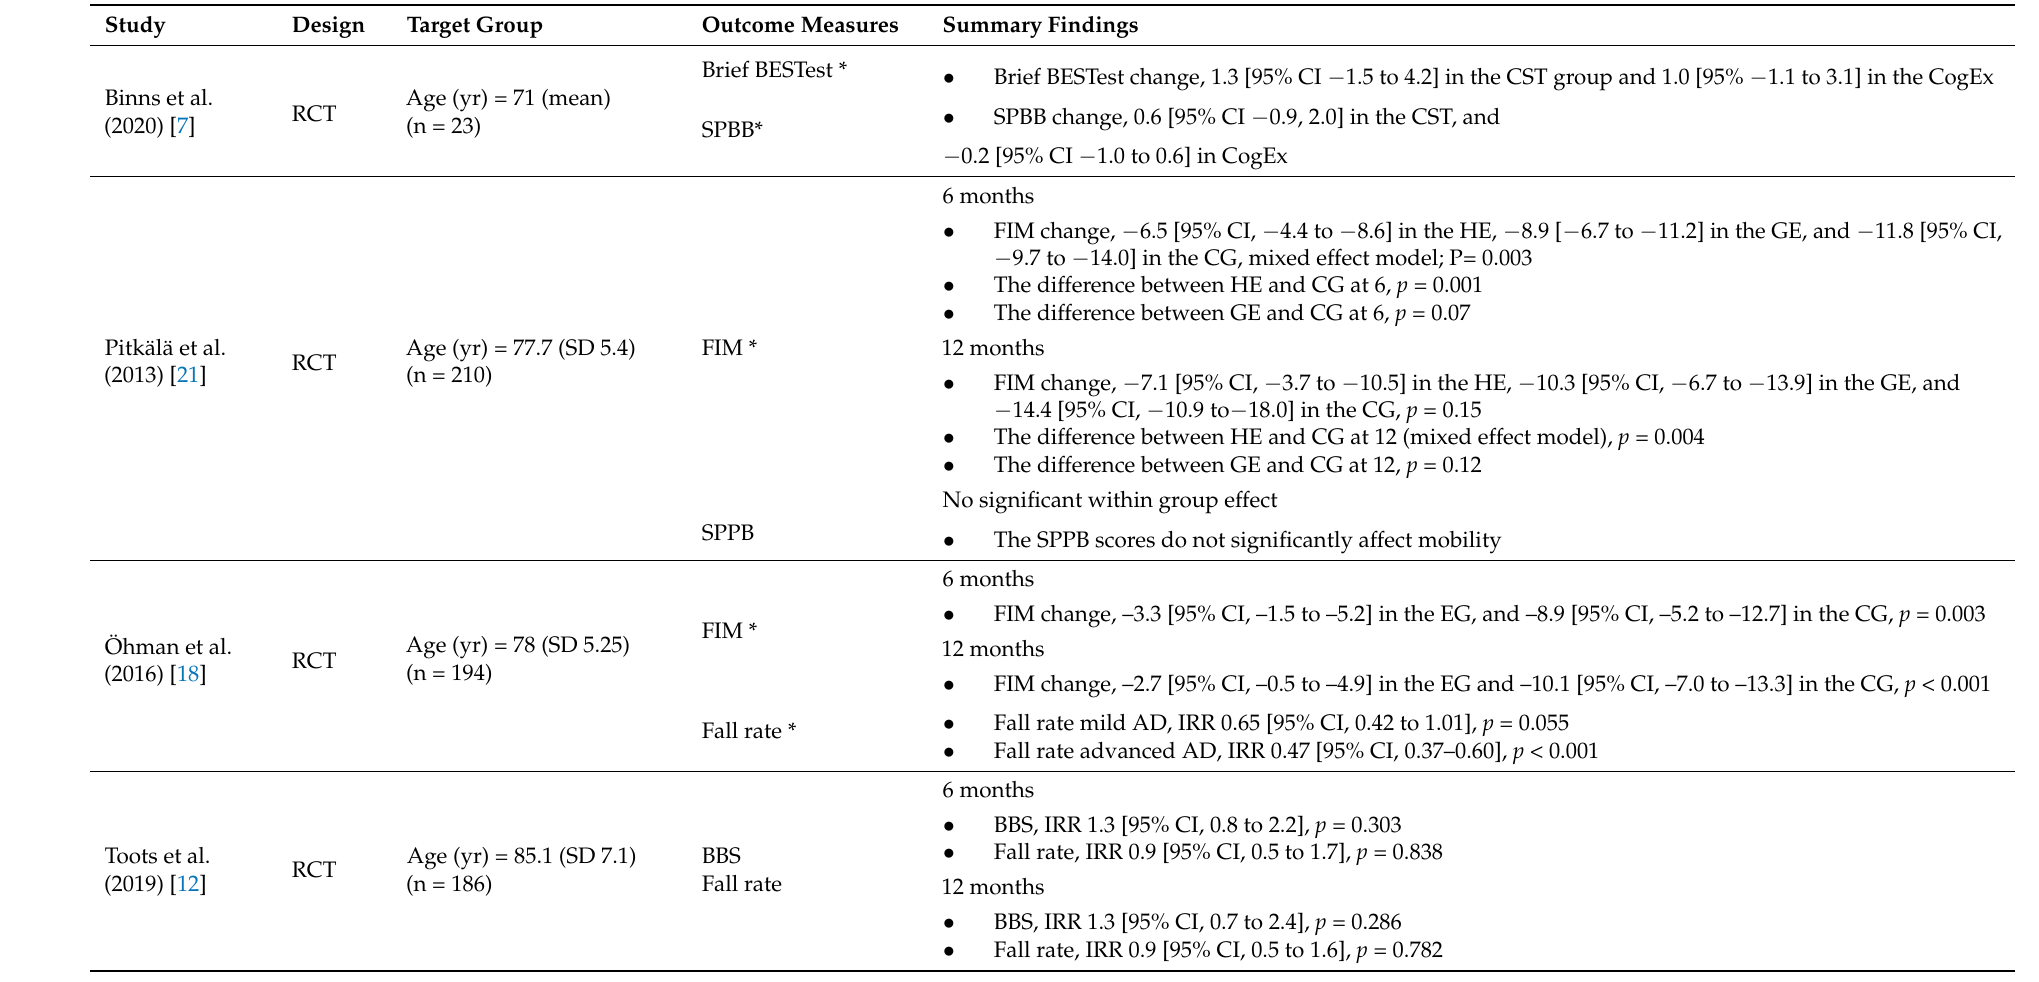
Table 3. Results to measure falls or postural stability of the included